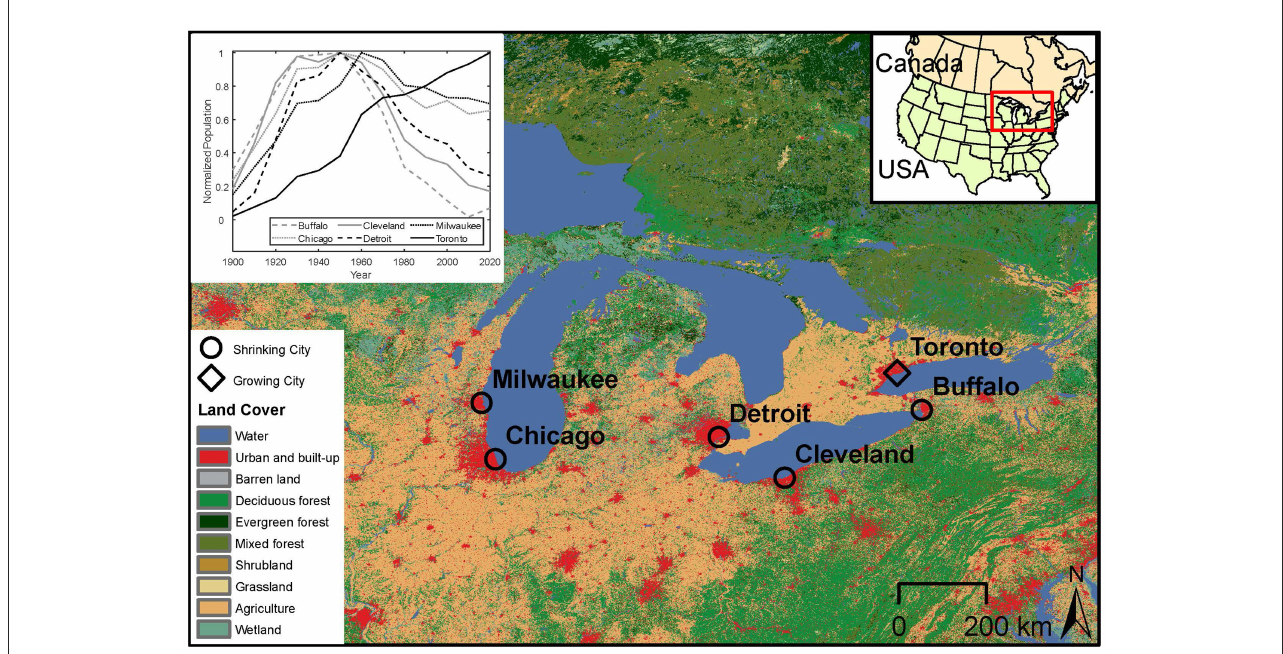
FIGURE1 Geographic locations of the shrinking cities (open circles) and the growing (open diamond) city within the Rust Belt region, including their long-term population trends. Land cover maps were acquired from the Multi-Resolution Land Characteristics (MRLC) National Land Cover Database (NLCD) 2019 (https://www.mrlc.gov/) for the United States and the Canada Center for Remote Sensing (CCRS) 2015 Land Cover of Canada